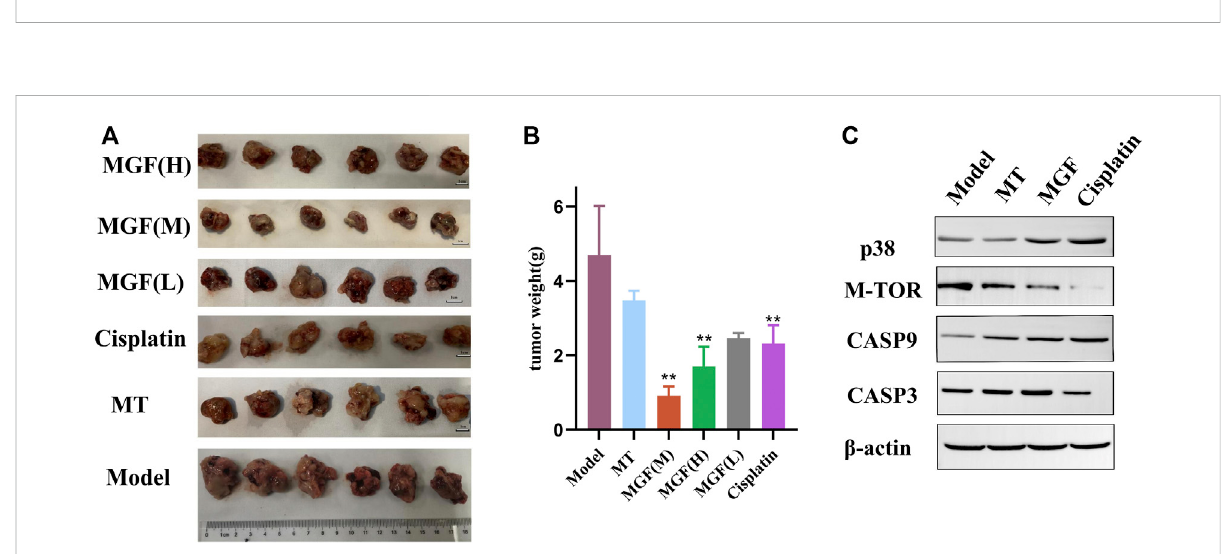
FIGURE 11 (I): KEGG pathway analysis of the differences between Ganoderma lucidum (GL) and Marsdenia tenacissima with Ganoderma lucidum co- fermentation